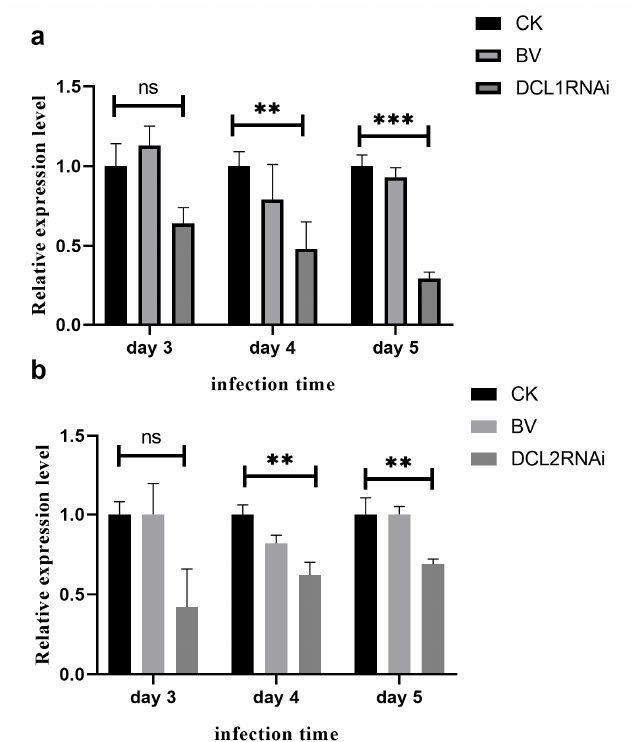
Figure 2. ( a ) Images of the infection of citrus fruits by P. italicum ; ( b ) infection diameter on the surface of the citrus fruits 3, 4, and 5 days after inoculation. WT (wild-type), BV (blank vector transformant), DCL1RNAi (Dicer-like 1 gene transformant), and DCL2RNAi (Dicer-like 2 gene transformant). Each bar represents a mean ± standard error ( n = 3), and the asterisk indicates a significant difference (***, p < 0.001).